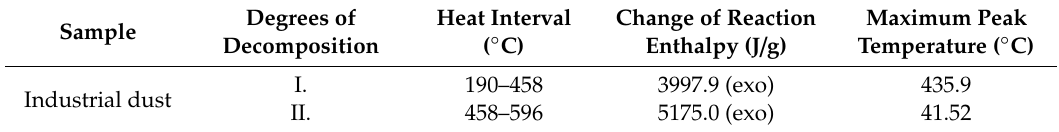
Table 3. Dependence of changes in reaction enthalpy of industrial dust samples on temperature.